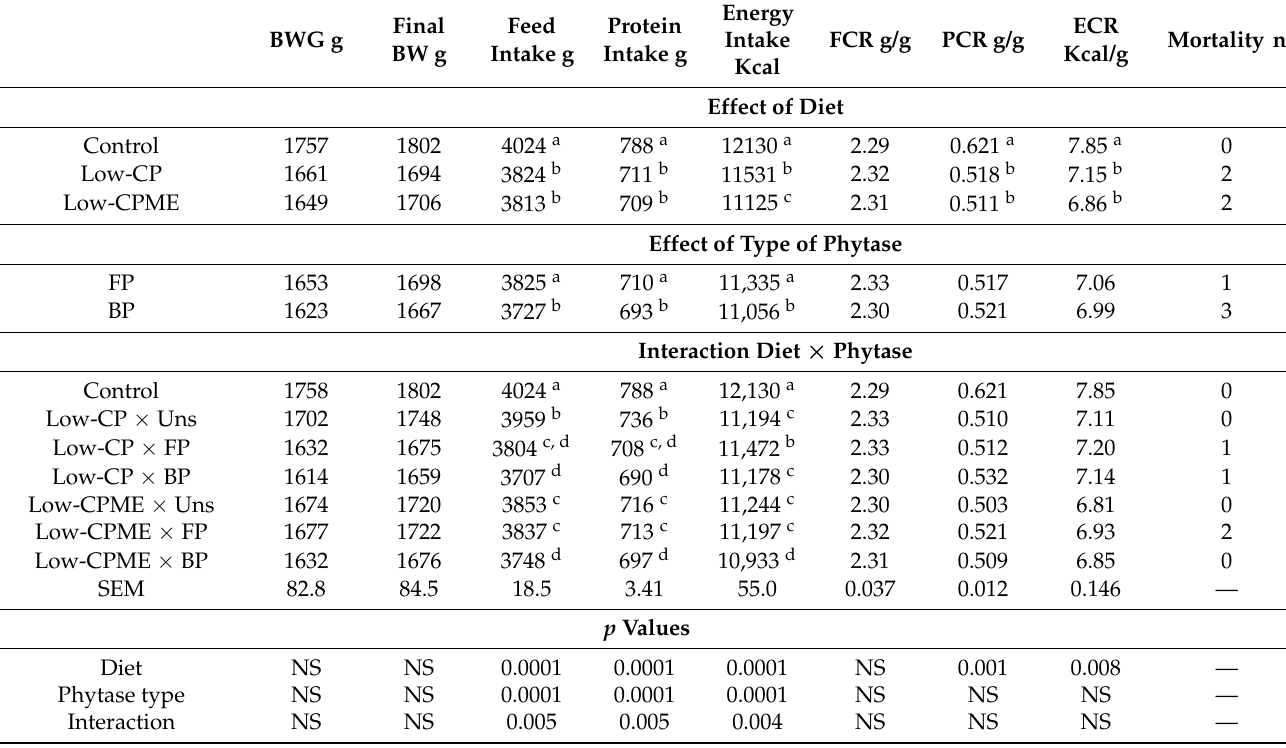
Table 2. Growth performance of broilers as affected by diet, type of phytase, and their interaction.